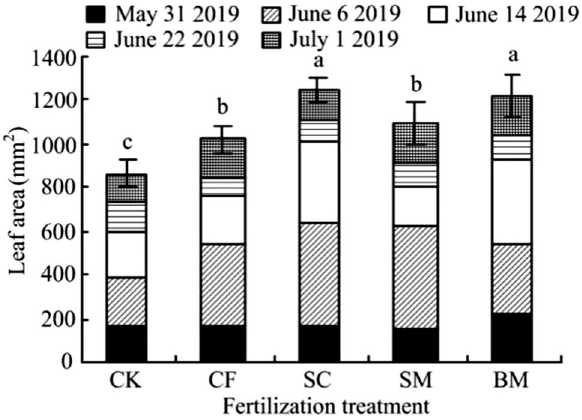
Figure 2. Effects of different fertilizer treatments on leaf area of Pear-jujube. Note : At different levels, each population mean follows a normal distribution with the same variance. The least significant difference (LSD) method was selected for analysis of variance in DPS software. Different lowercase letters indicate a significant difference between treatments ( P < 0.05).